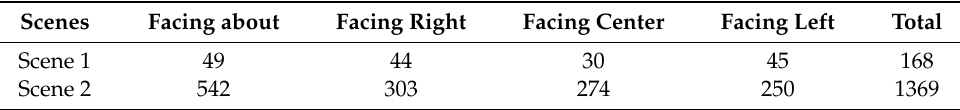
Table 3. Head orientation: ground truth information for both the scenes.